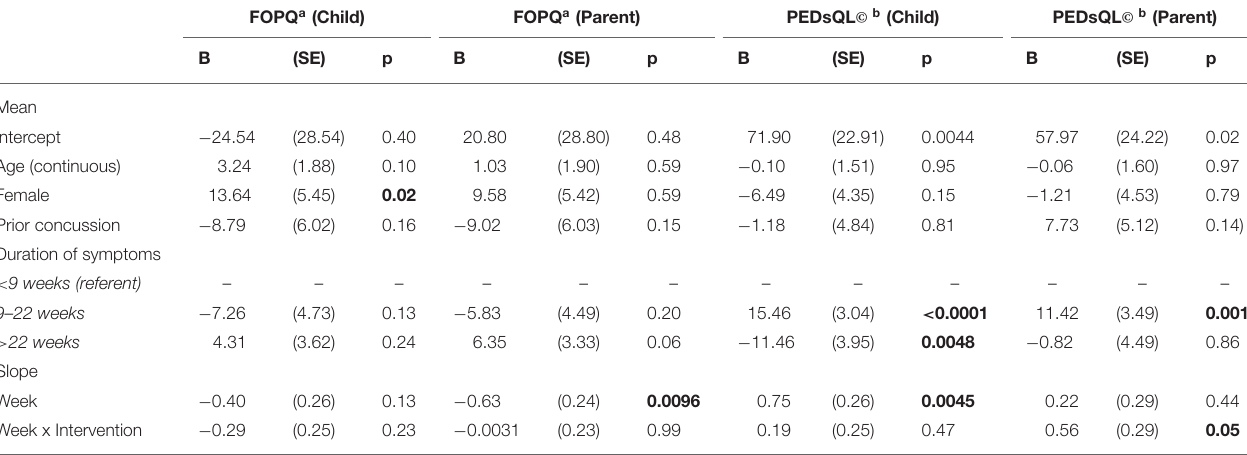
TABLE 3 | Linear mixed model examining the impact of the Sub-Threshold Exercise Program (STEP) intervention on concussed youth on outcomes of fear avoidance of pain and health-related quality of life, adjusted for age, sex, duration of symptoms, and prior concussion, Seattle WA